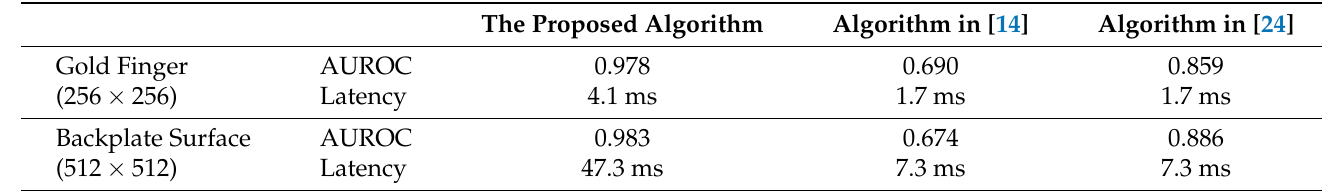
Table 4. Summary of AUROC and inference latency for various